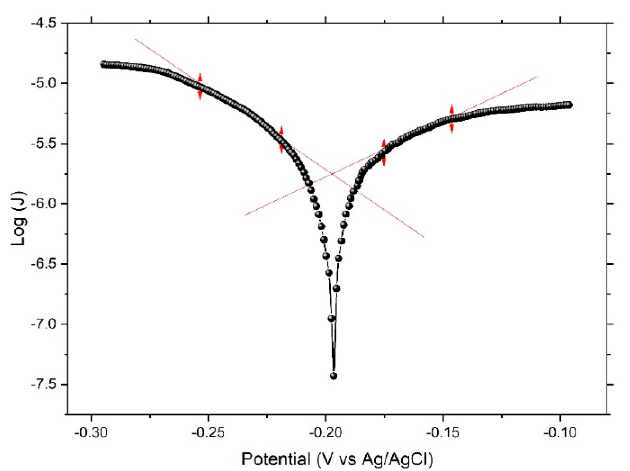
Figure 3. Linear polarization curve (Tafel’s curve) for the Ni 60 Pd 20 P 16 B 4 glassy alloy ribbon sample in 0.1 M H 2 SO 4 solution. Table 2. Summary of electrochemical parameters obtained from the polarization curve of the